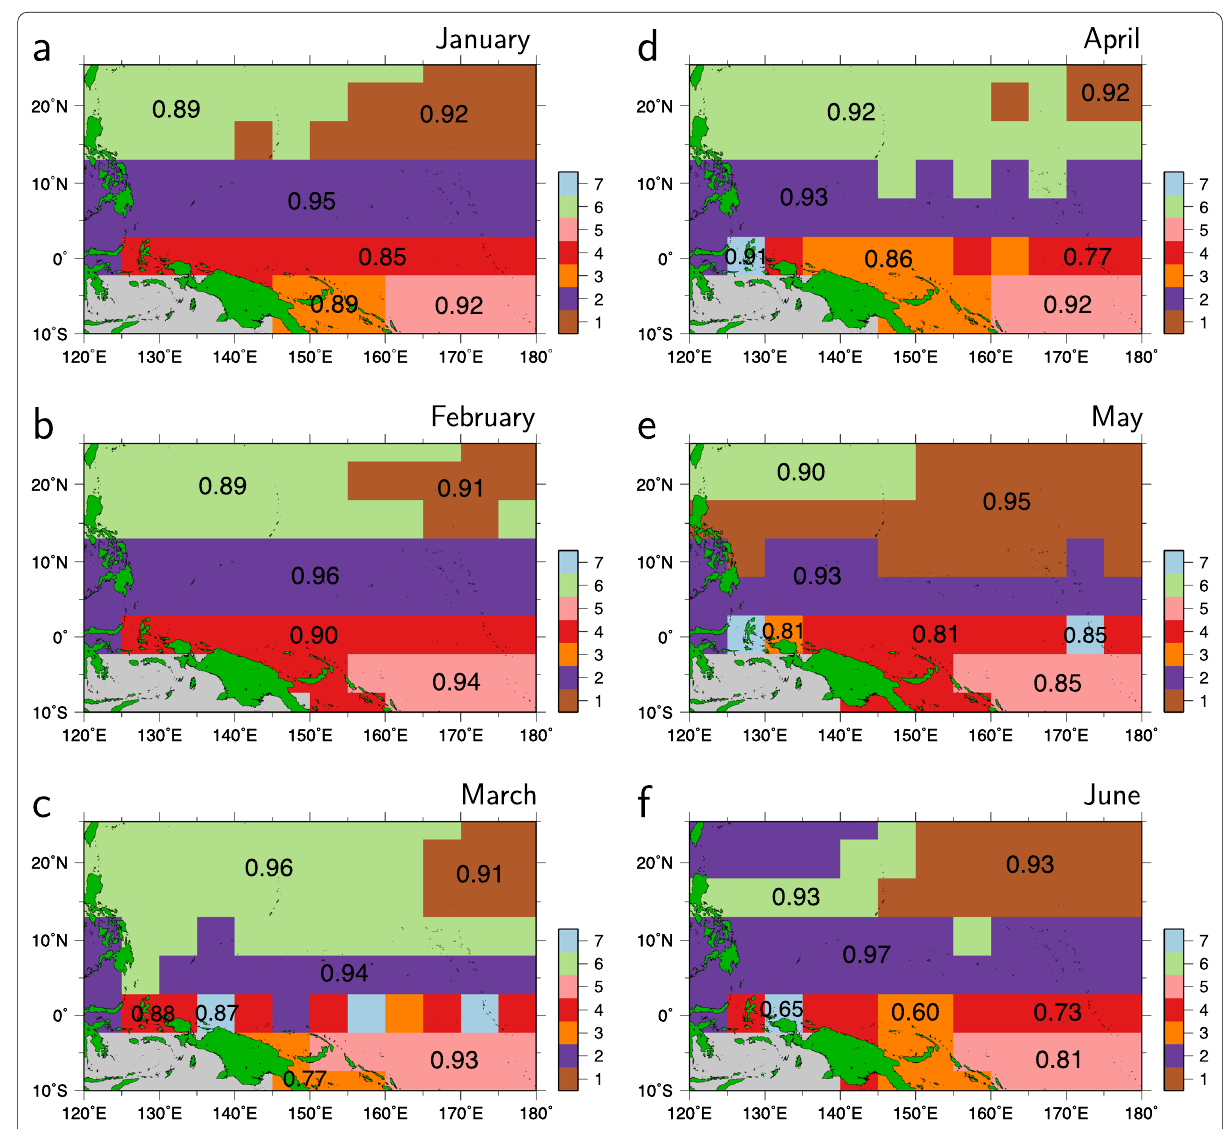
Fig. 2 Divisions of the study region up to 7 areas applying the cluster analysis to Argo CTD profiles collected from a January to l December. Area numbers from 1 to 7 are indicated in the color bar in the lower right corner of each panel. Numeric values in areas divided by the cluster analysis indicate correlation coefficients between altimetric SSH and sea surface dynamic height relative to the pressure level of 1000